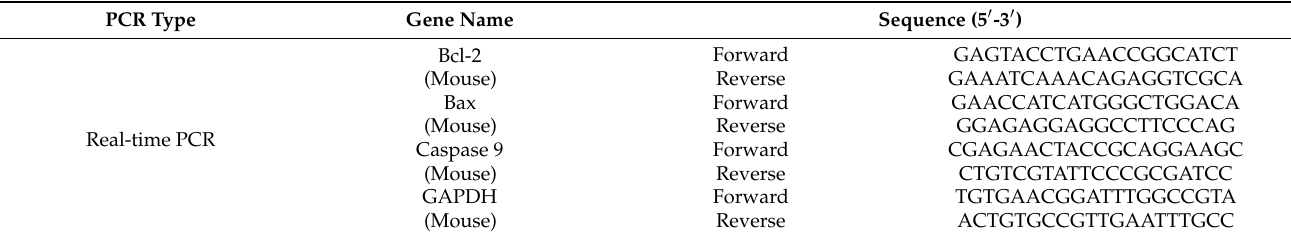
Table 3. Sequences of mouse primers used for